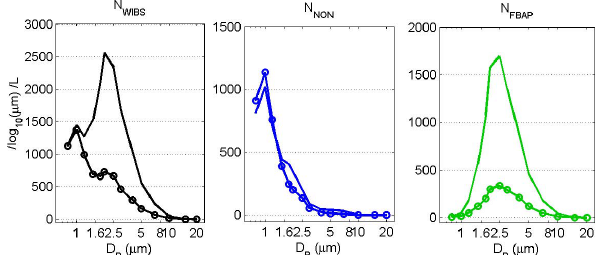
Fig. 6. Number size distributions in the understorey and above canopy for (i) N WIBS , (ii) N NON and (iii) N FBAP . Circular points denote above-canopy measurements.